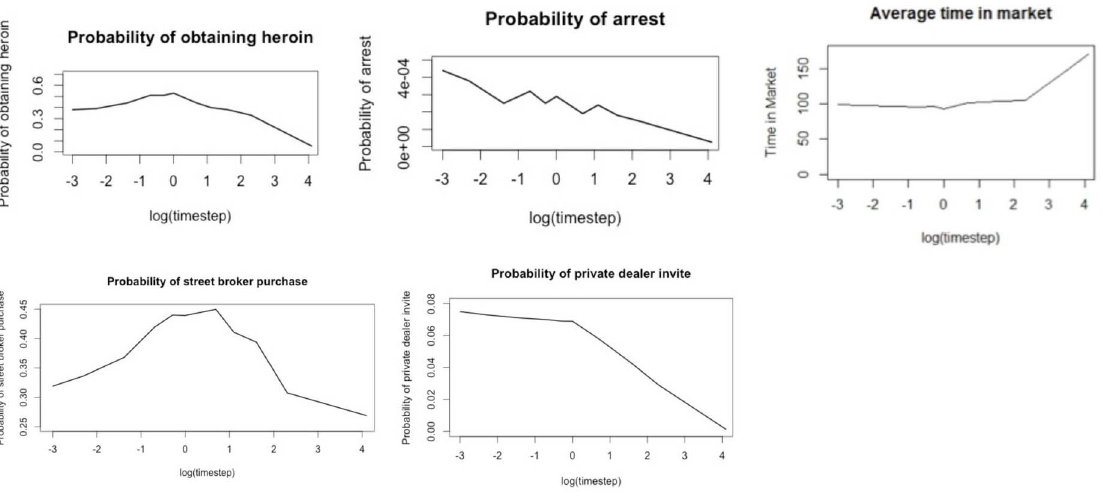
Figure 1. Plots of average summary statistics versus log time step, where zero corresponds to 1 minute. The curves all show clear shifts as the time step moves away from 1 minute.